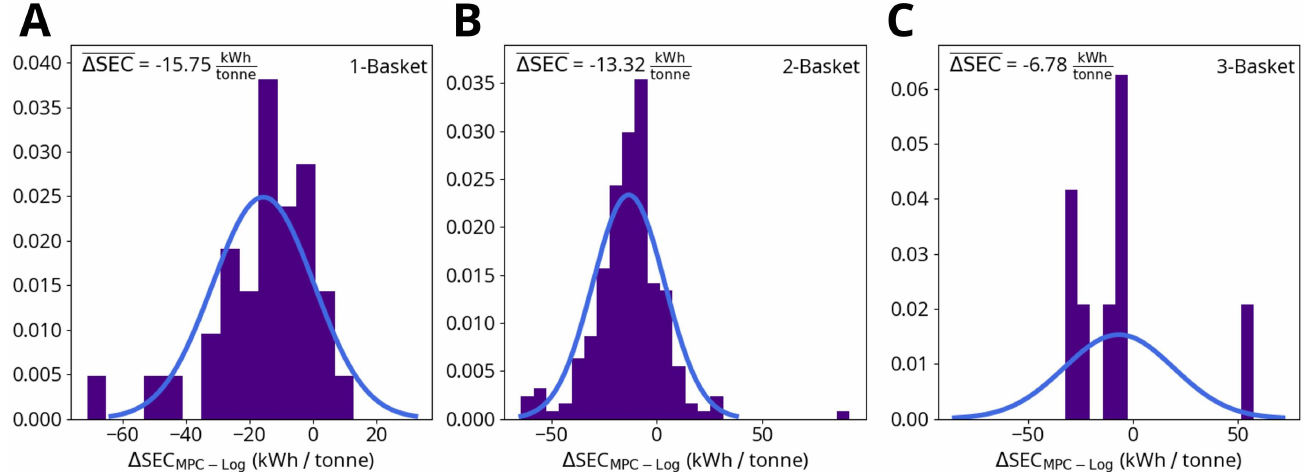
Figure 9. Change in specific energy consumption (SEC) due to MPC for ( A ) one-basket heats, ( B ) two-basket heats and ( C ) three-basket heats. ∆ SEC is calculated by subtracting the logged SEC up to the point where the model predicts steel meltdown from the MPC simulation